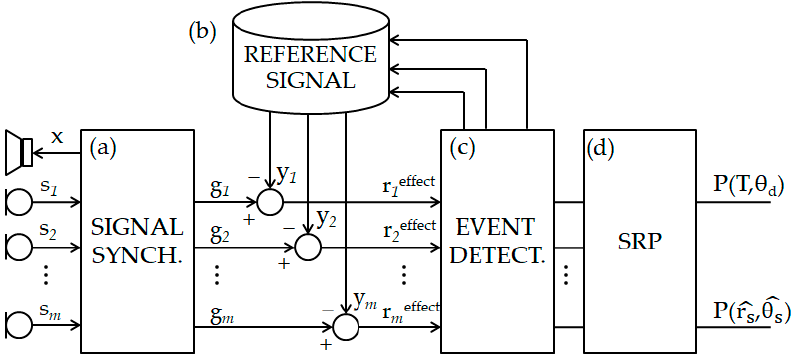
Figure 5. Block diagram of the proposed active localization method: ( a ) Step to synchronize the measure signals; ( b ) Step for reference signals defined as measured signals if no event is detected; ( c ) Step for event detection; ( d ) Step for SRP using Equations (7)–(9).